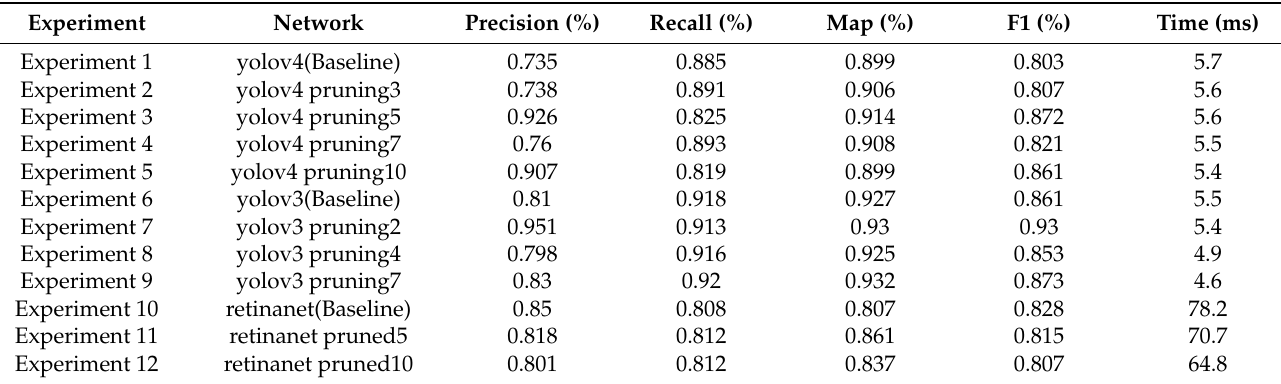
Table 1. Results of object detection